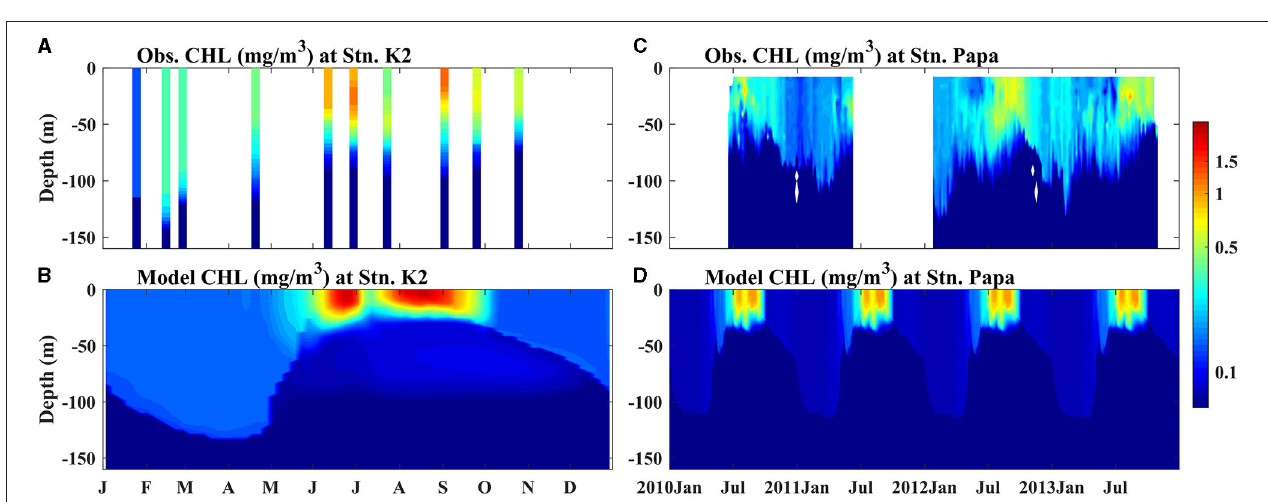
FIGURE 1 | Comparison of sea surface temperature (SST; ◦ C), mixed layer depth (MLD; m), and surface nitrate (SNO 3 ) between the model results (blue curve) and (A–C) cruise measurements during 2005–2013 (red hollow circle) at Station K2 (Stn. K2) and (D–F) Argo measurements during 2008–2014 (hollow circle) at Station Papa (Stn. Papa). The float numbers (and colors) (in D–F ) are as follows: 5143 (black), 6400 (purple), 6972 (red), 7601 (green), 6881 (yellow), and 7641 (gray).